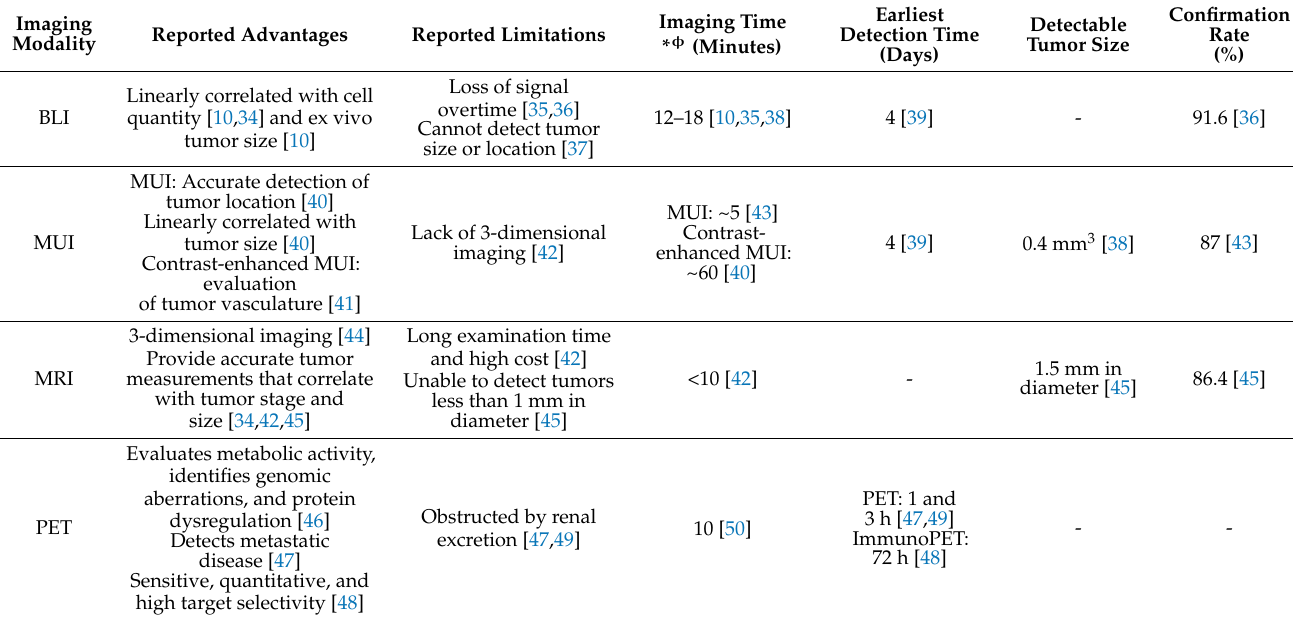
Table 1. A summary of noninvasive imaging